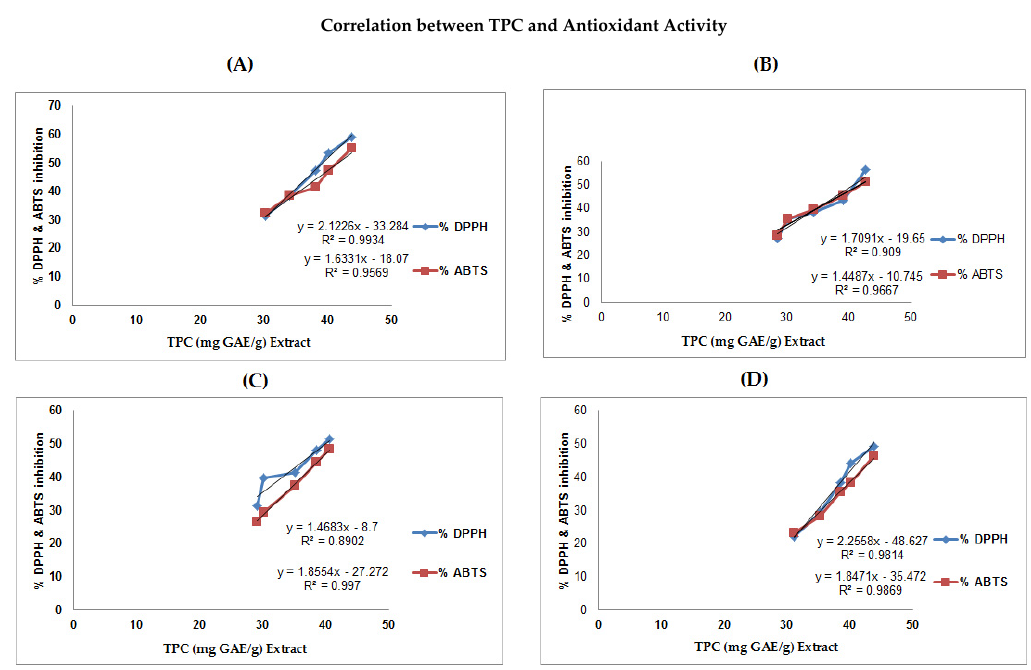
Figure 2. Correlation between total phenolic content in the methanolic extracts of A. nitida various parts (leaves, stem bark, seeds, and roots) versus percent antioxidant activity. The regression values are; ( A ) leaves (DPPH, R 2 = 0. 9934; ABTS, R 2 = 0.9569), ( B ) stem bark (DPPH, R 2 = 0. 909; ABTS, R 2 = 0.9667), ( C ) seeds (DPPH, R 2 = 0. 8902; ABTS, R 2 = 0.997), and ( D ) roots (DPPH, R 2 = 0. 9814; ABTS, R 2 = 0.9869).